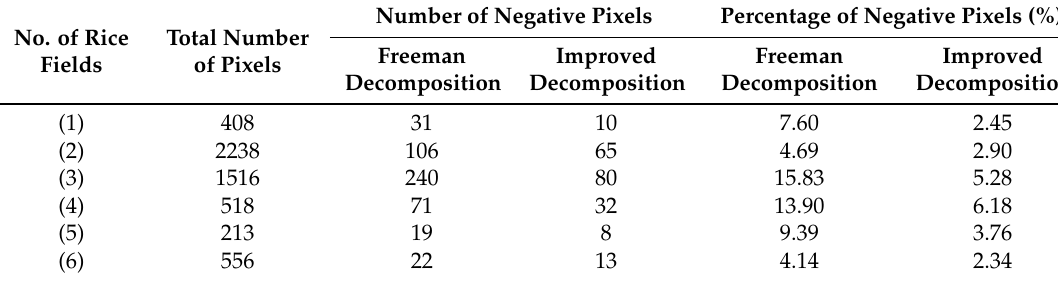
Table 2. Numbers of negative pixels in six rice